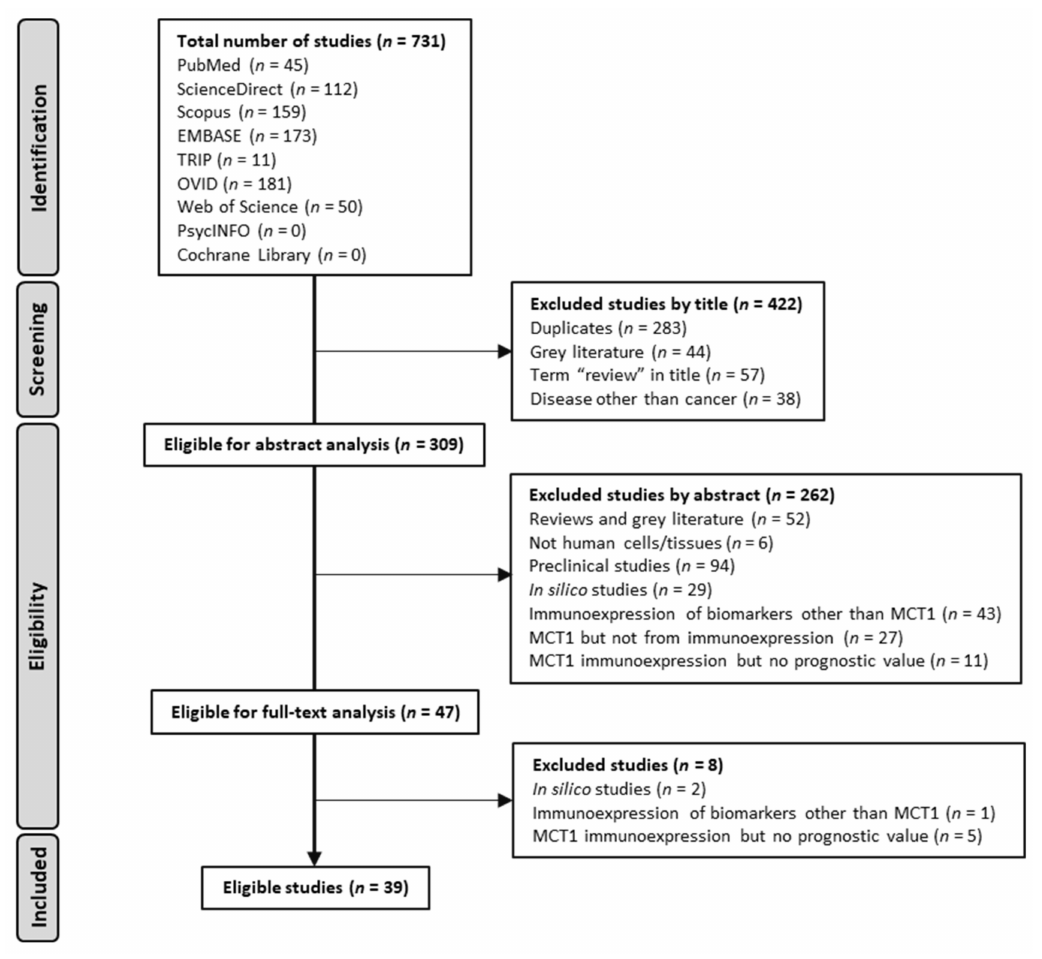
Figure 2. PRISMA 2020 flow diagram for study selection (adapted from